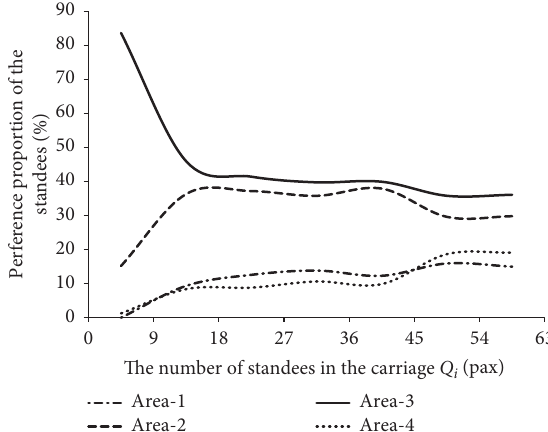
Figure 3: Changes in the proportion of passengers choosing each